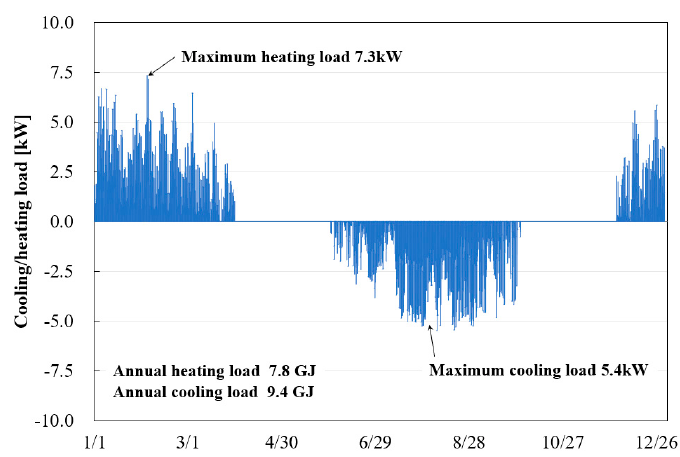
Figure 9. Total heating and cooling load of a residential house.